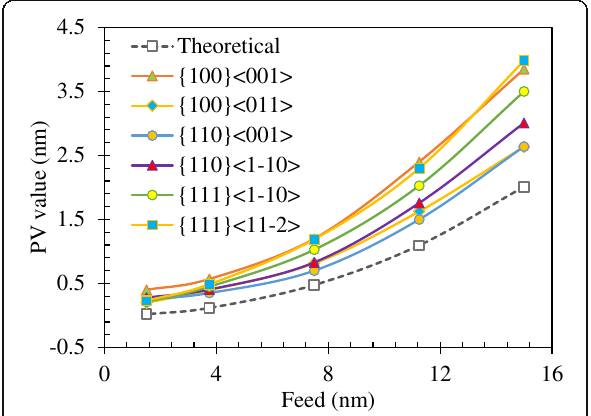
Fig. 8 PV generated at different cutting directions